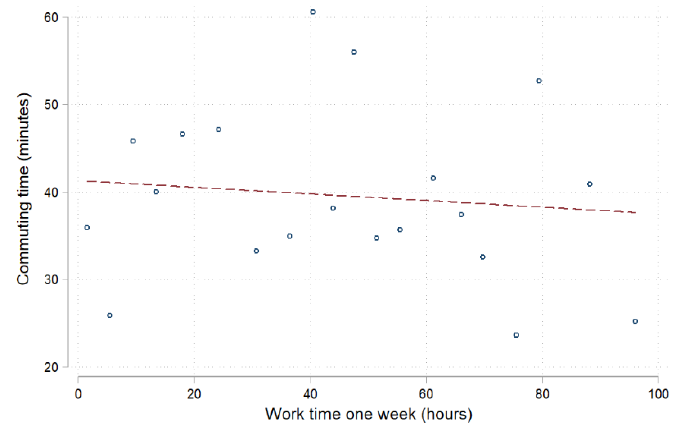
Figure 2. Commuting time and work time for one week.